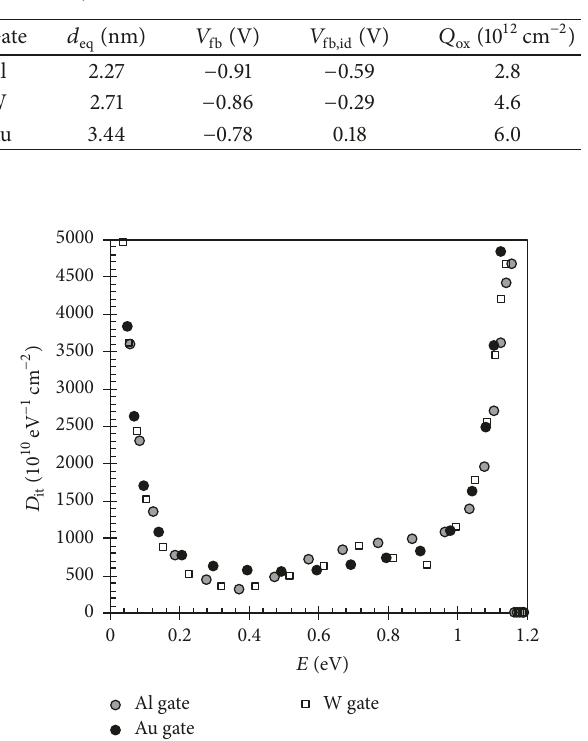
), flat band voltage ( 𝑉 ) eq fb ). ox